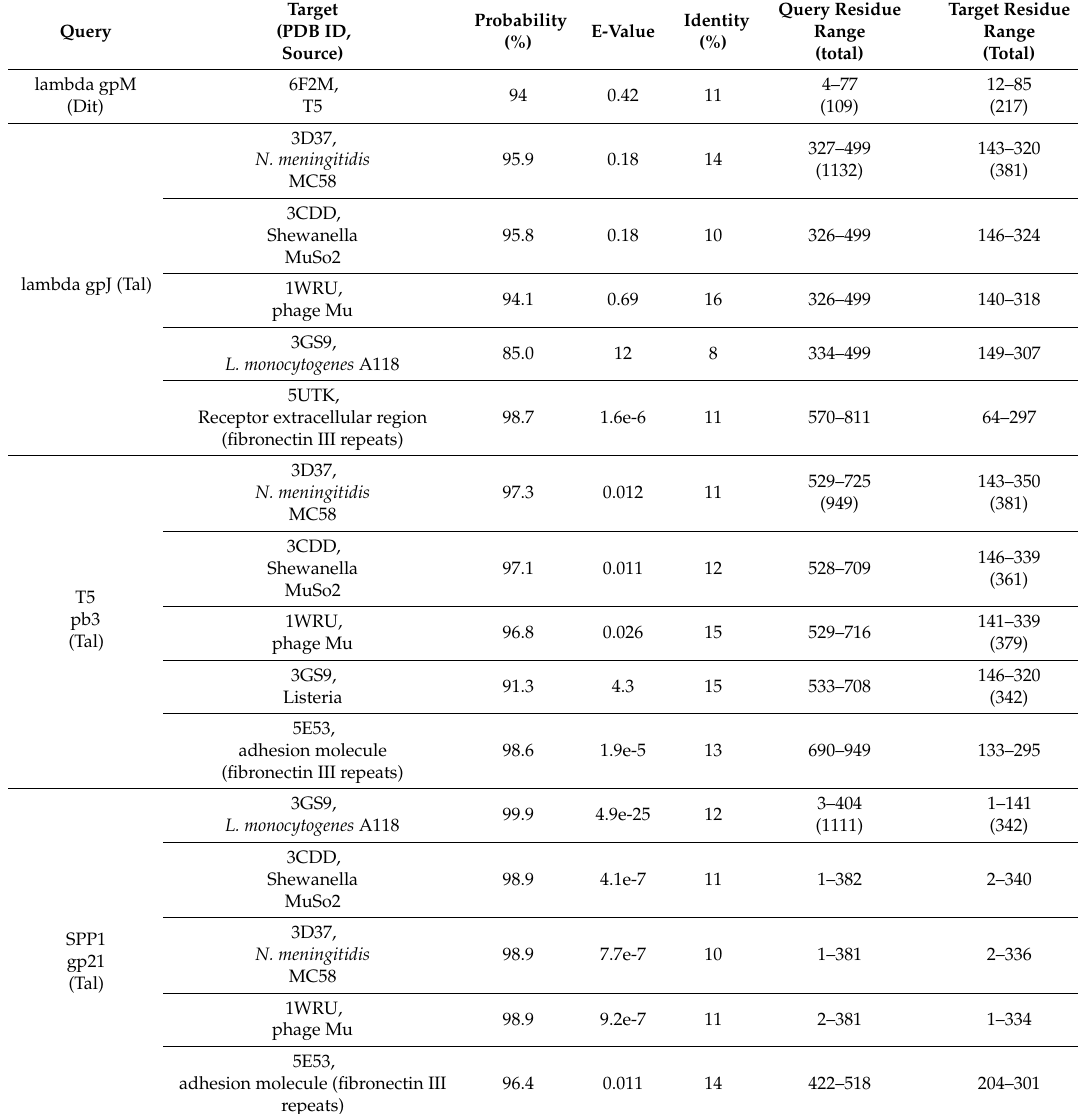
Table 1. HHpred hits for the Dit and Tal proteins of lambda, T5, and